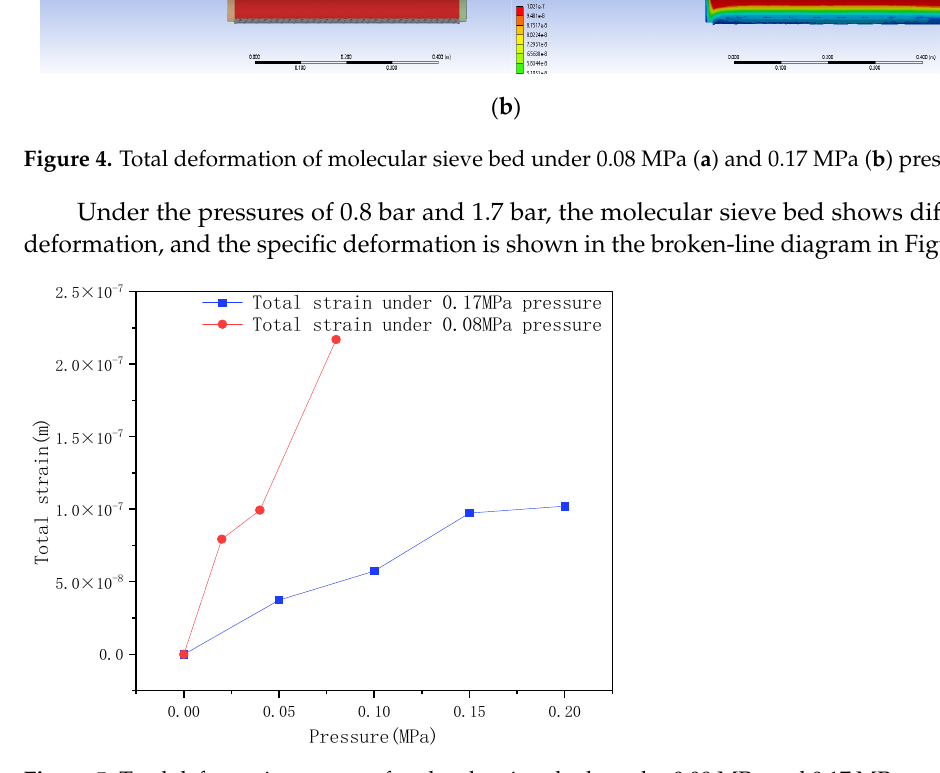
Figure 5. Total deformation curves of molecular sieve beds under 0.08 MPa and 0.17 MPa pres- sures.